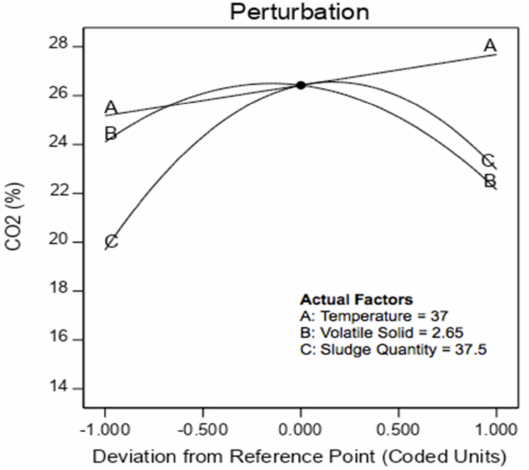
Figure 32. Perturbation plot shows the effect of all factors on CO 2 %.